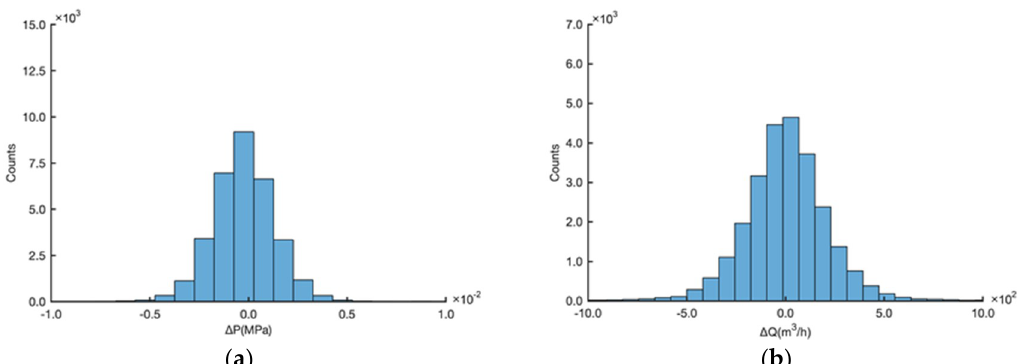
Figure 5. Histograms of ( a ) pressure and ( b ) flow fluctuations at the pumping station.